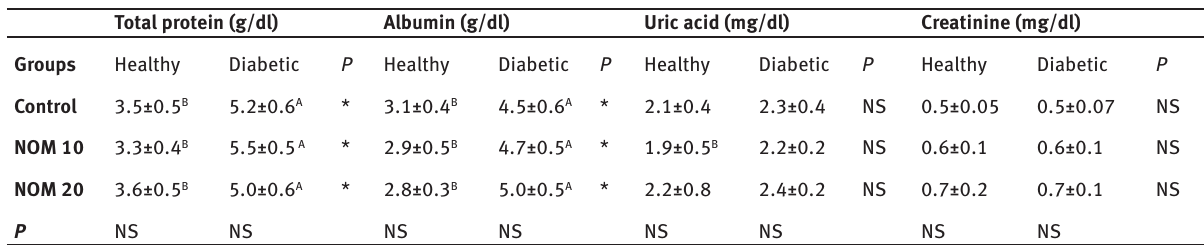
Table 4: Effects of Nannochloropsis oculata microalgae (NOM) at rates of 10 and 20mg.kg -1 of body weight on the serum concentrations of total protein, albumin, uric acid and creatinine in healthy and diabetic